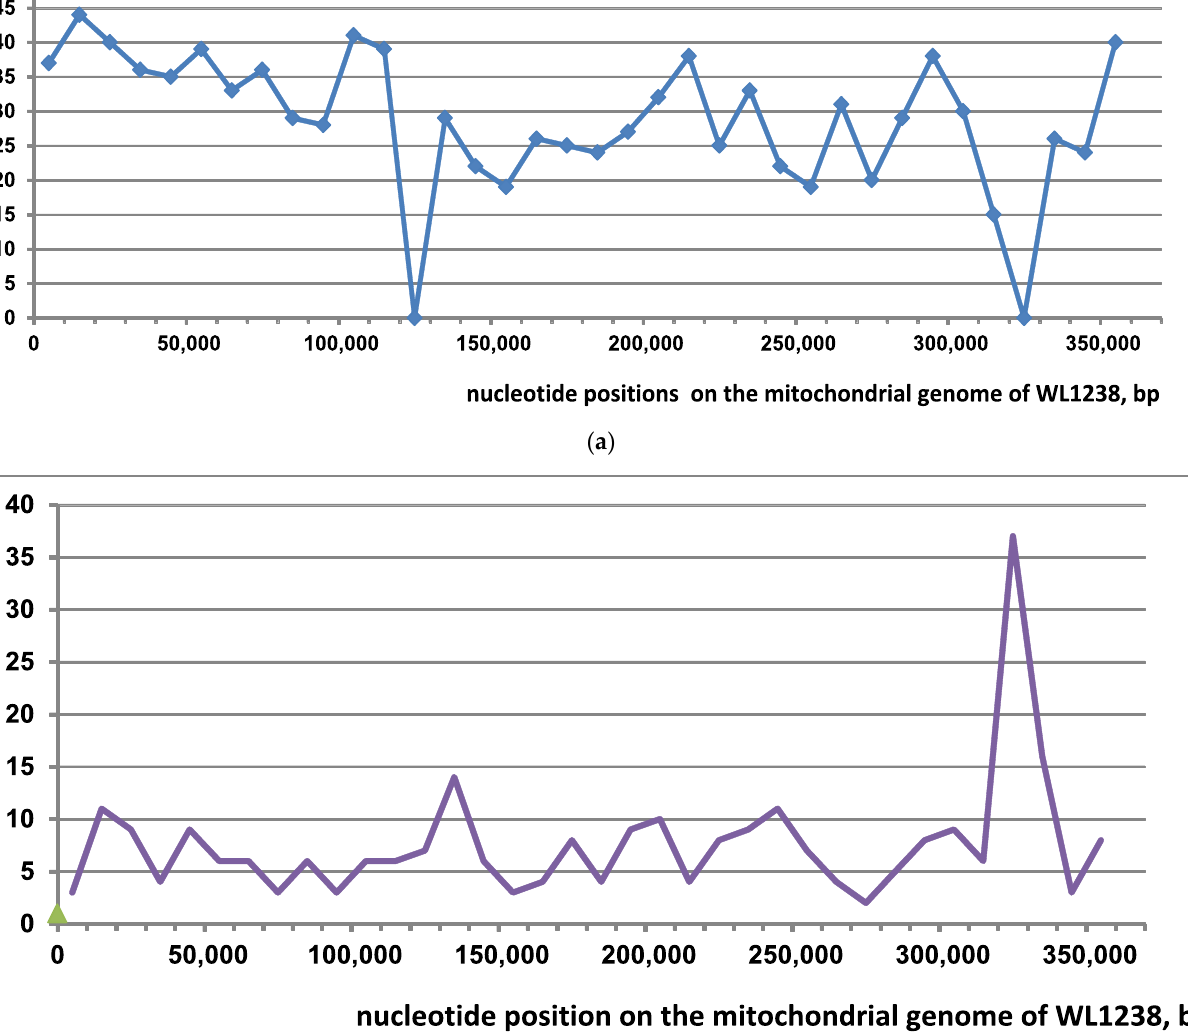
Figure 5. ( a ) Distribution along intervals of 10 Kb of the number of differences specific to the mitochondrial genomes of representatives of the M1 clade from the reference mitochondrial genome of accession WL_1238. ( b ) Distribution along intervals of 10 Kb of the number of differences from the reference mitogenome met in all representatives of the M2 clade except for the accessions with abyssinicum -related